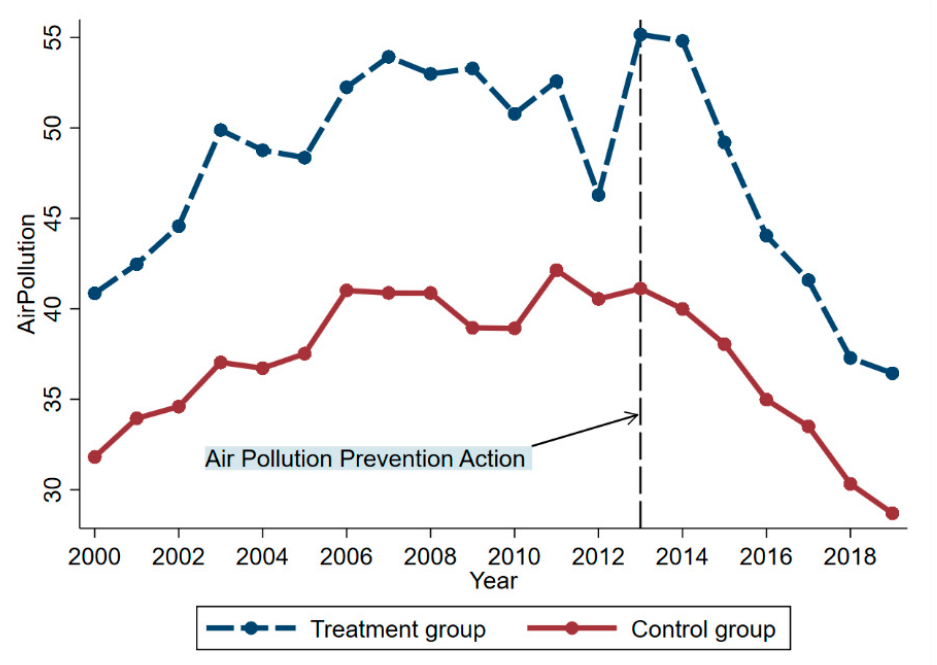
Figure 2. Temporal trends of AP in the treatment and control provinces.